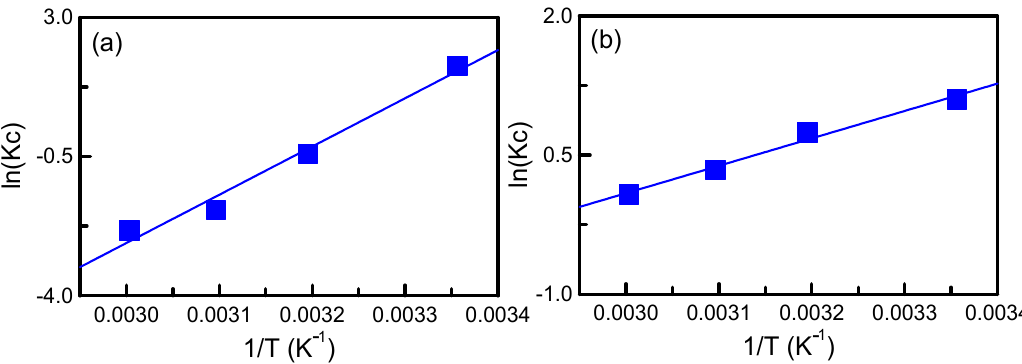
Figure 11. Plot of equilibrium constant versus temperature by using Van’t Hoff equation: ( a ) SBA ‐ 15/APTES; ( b ) SBA ‐ 15/PEHA.